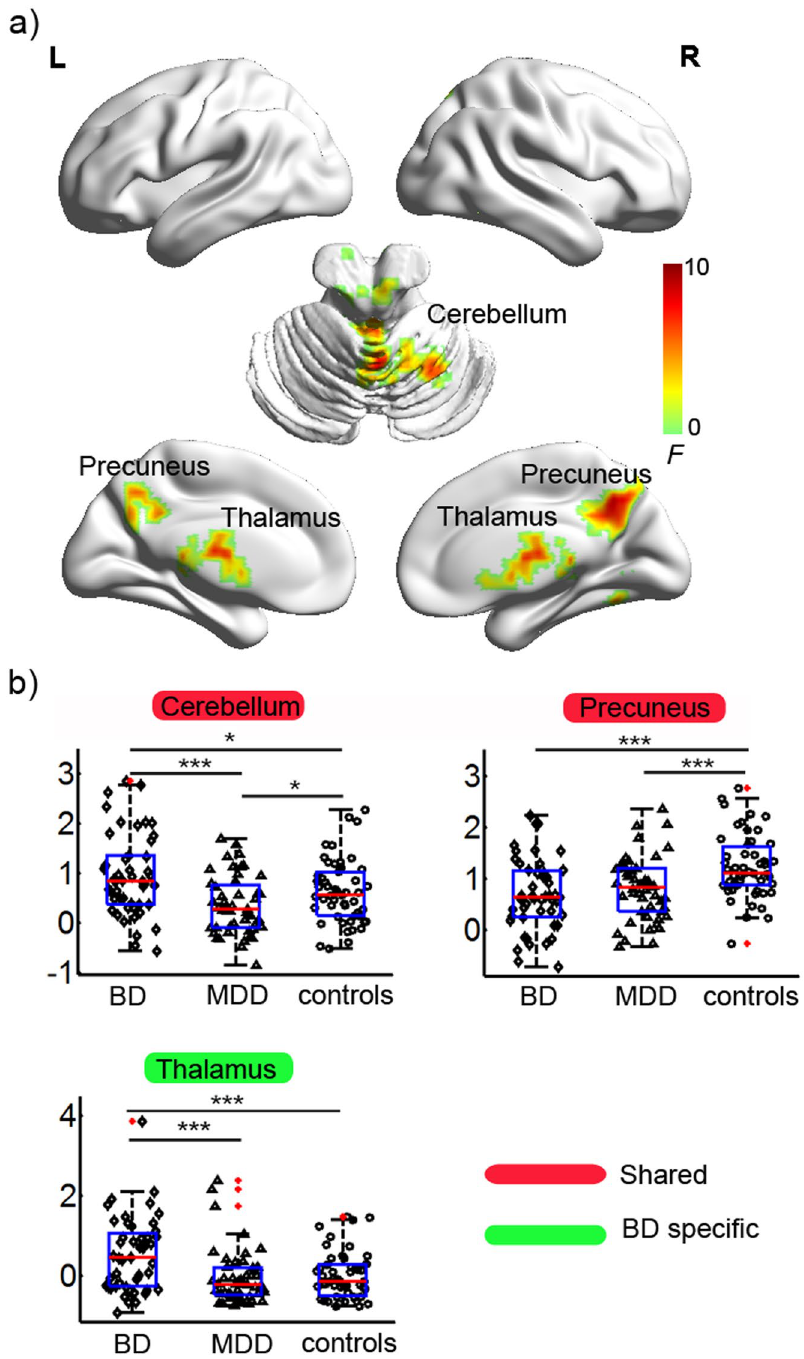
Figure 2. Statistical results for the sFCS in the BD, MDD, and healthy controls. ( a ) Clusters showing significant group effects ( p < 0.001 Alphasim corrected, ANCOVA). The brain surfaces were visualized using BrainNet Viewer (http://www.nitrc.org/projects/bnv/). ( b ) Post-hoc analyses of the sFCS for the significant clusters. The ‘BD’ type indicates that the sFCS in the cluster was specifically altered in the BD patients but not in the MDD patients. The ‘shared’ type indicates that the cluster with altered sFCS was detected in both the BD and the MDD patients. ◊ , ∆ , and ○ in the scatter plot indicate the mean lFCS values of a given cluster for a subject in the BD, MDD, and control groups, respectively. Red dots indicate outliers. The box plot shows the median (red line), interquartile range (blue lines), and sample minimum and maximum values (dark lines). The horizontal lines on top indicate pairwise comparisons that survived statistical thresholds: *** p < 0.001; ** p < 0.01; * p < 0.05. Abbreviations: sFCS, short-range functional connectivity strength; BD (MDD), bipolar (major depressive) disorder; B (L, R), bilateral (left,